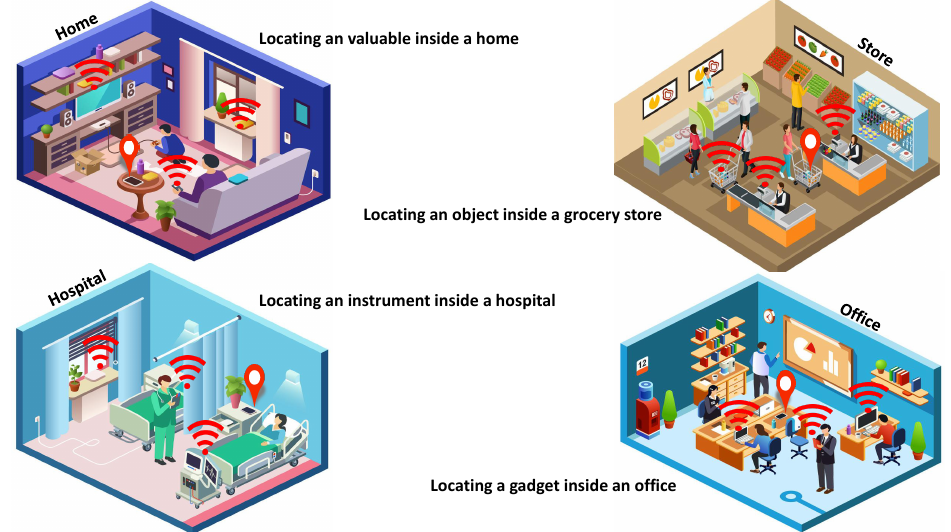
Figure 1. Pre-deployed BLE based IoT Network in Different Indoor